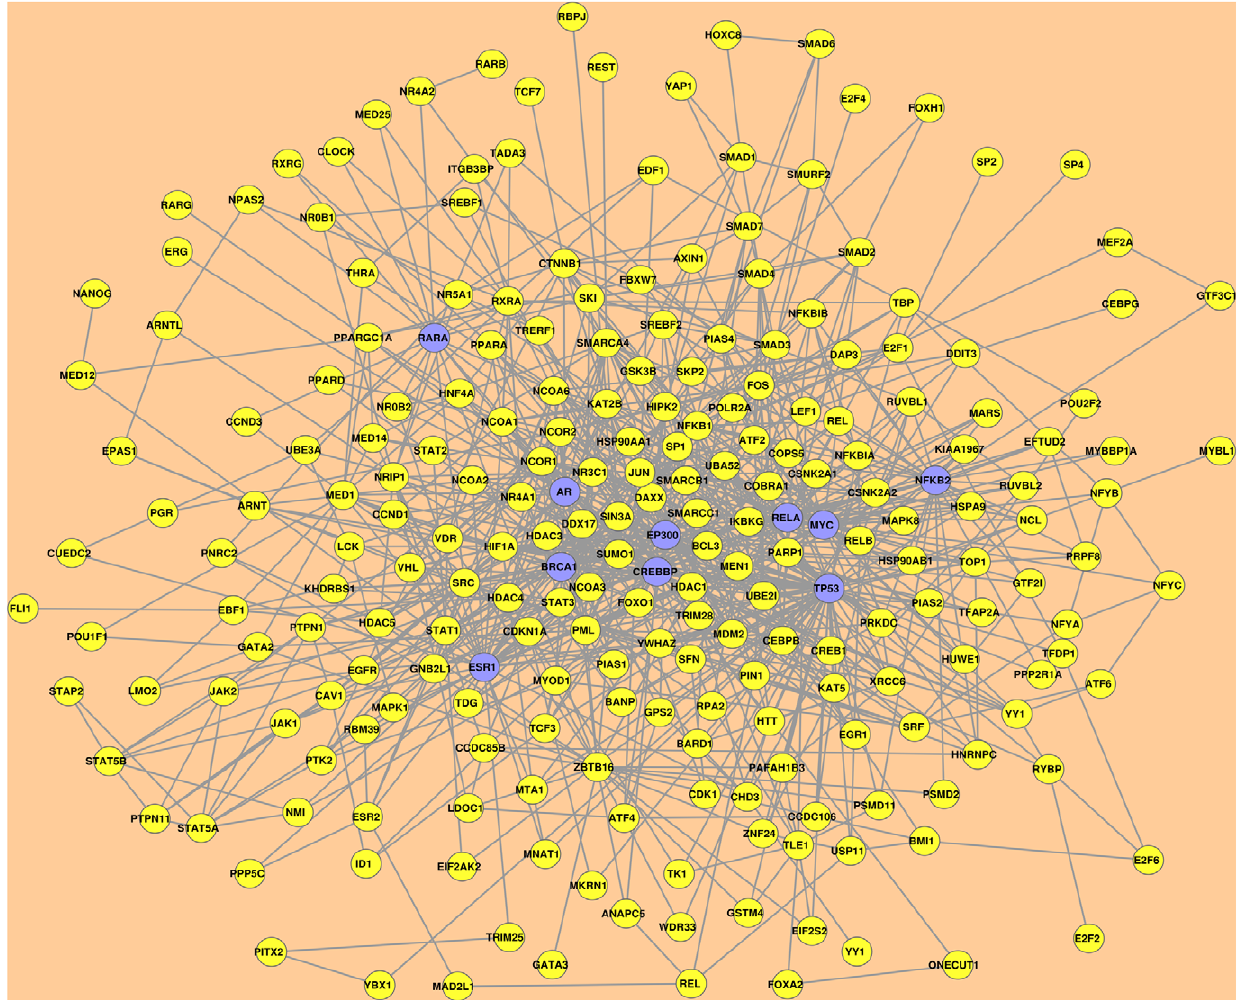
Figure 2. The minimal connected network of TFs regulated in cancer cell lines. The Snow web tool identified a significant human curated protein-protein interaction subnetwork involving 70 out of the 88 TFs correlatively regulated in cancer cell lines. The first connected component as shown here is considered as the minimal connected network (MCN) connecting these TFs. Each node represent a protein. Edges are the protein- protein interactions validated by at least two experimental evidences. Nodes shaded in violet represent the top ten most central TFs in the MCN. Node-ranking was based on the betweenness centrality scores.